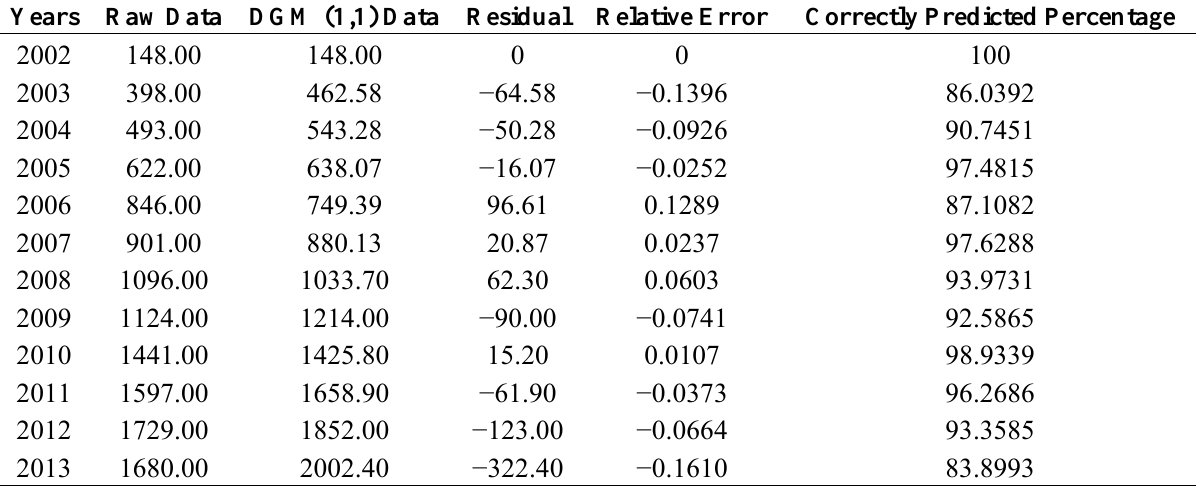
Table 4. Forecast data using the DGM (1,1) model.